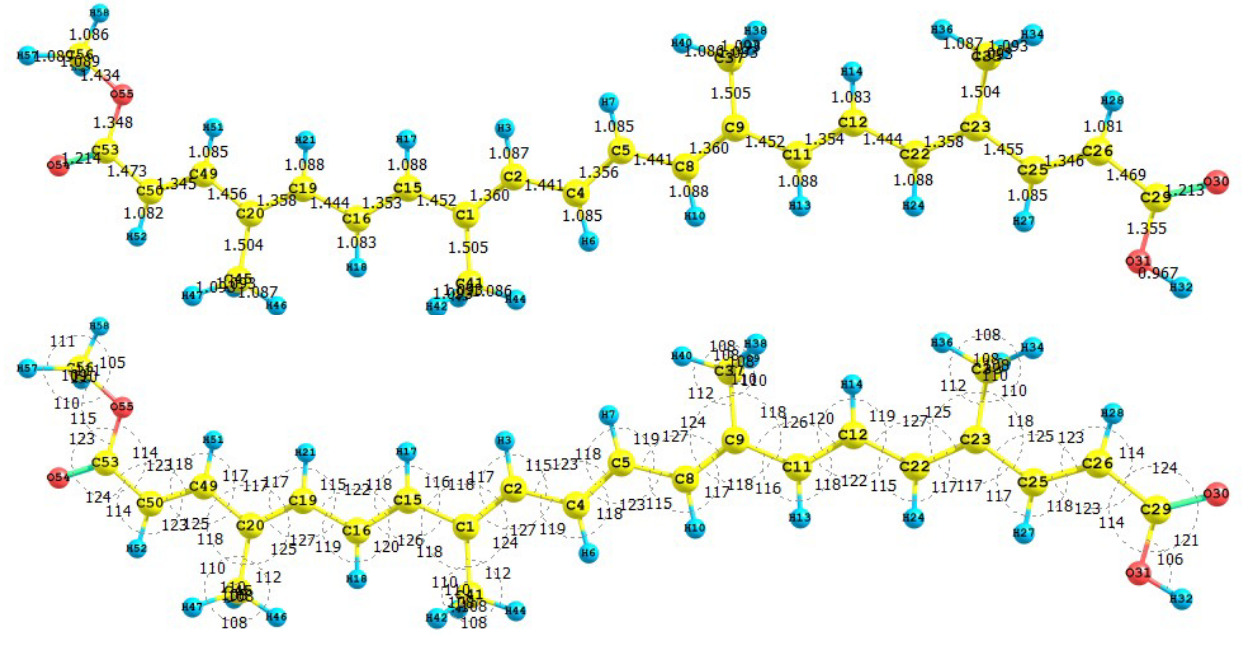
Figure 5. Interatomic bond distances ( Å ) and bond angles (deg) for the transbixin molecule.